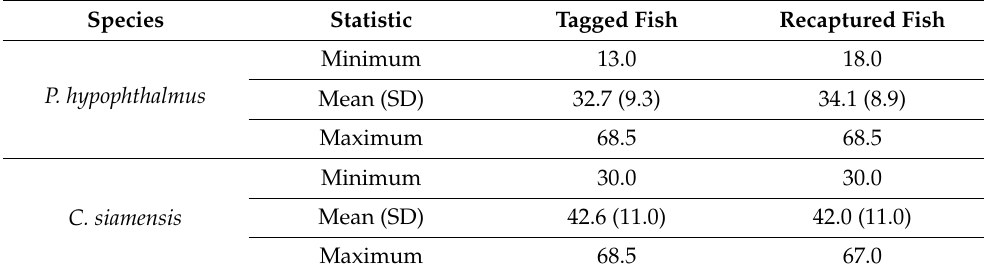
Table 3. Summary of fish body sizes (total length) for tagged and recaptured fish. Total length is reported in